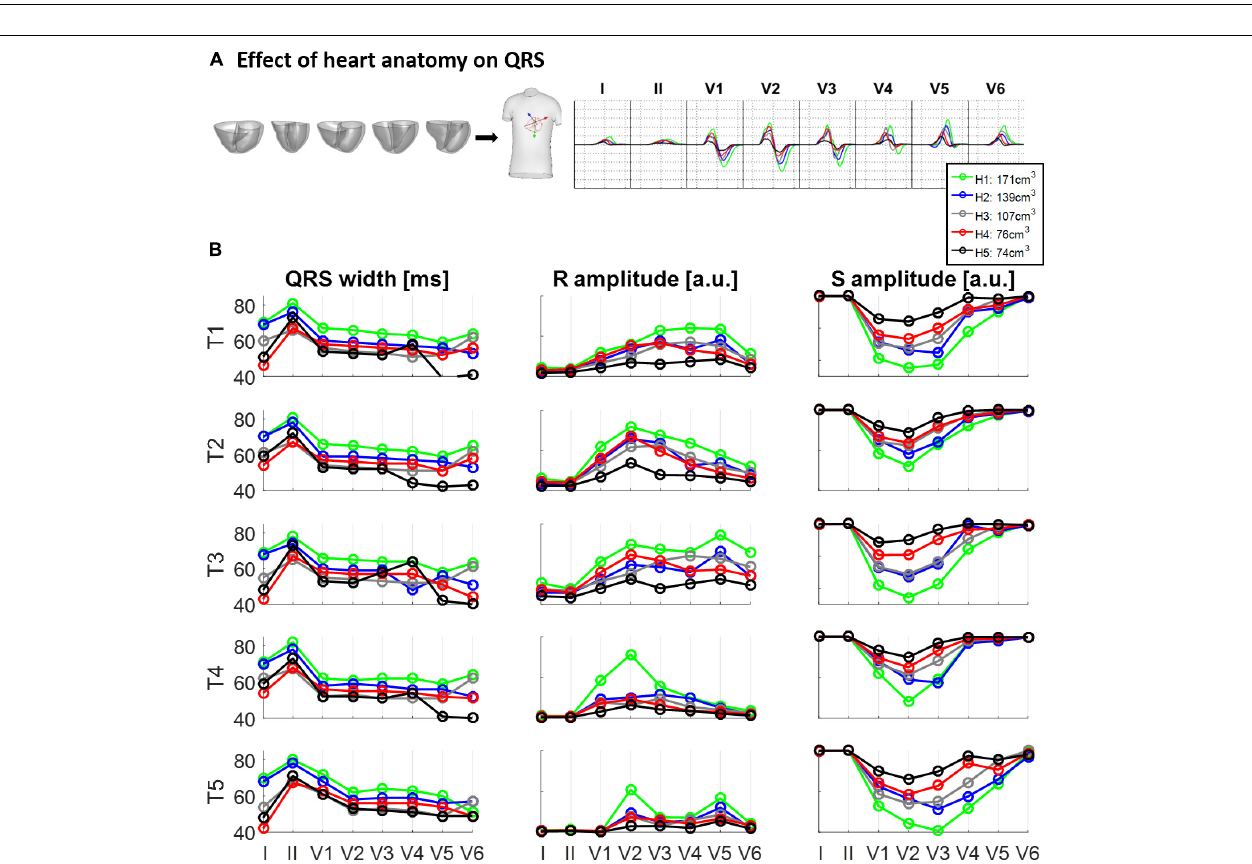
FIGURE 3 | Effect of ventricular geometry on QRS duration, and S and R wave amplitude. (A) Simulated QRS complexes obtained for five ventricular geometries placed in the torso-pose of Subject 3 (T3). (B) QRS duration (left), S and R amplitude (middle and right, respectively) obtained from simulations using the five ventricular geometries (H1 to H5) placed in each of the five torso-poses (T1 to T5). The term “a.u.” stands for arbitrary